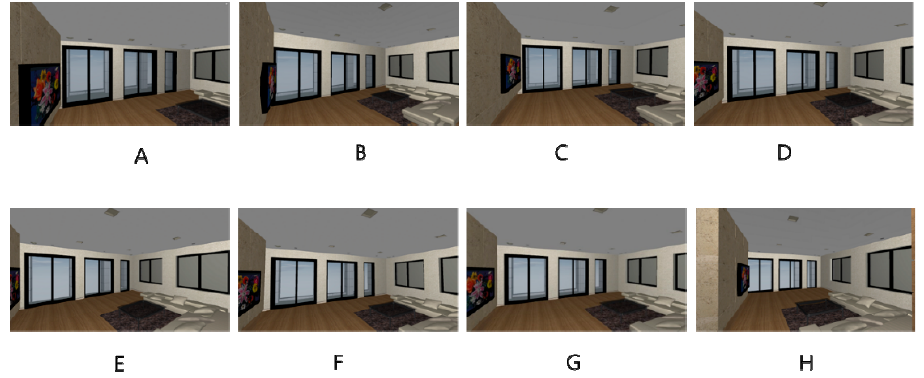
Figure 3. Perspective view of the selected spaces (Ceiling height varied for A – D , Base scenarios = A